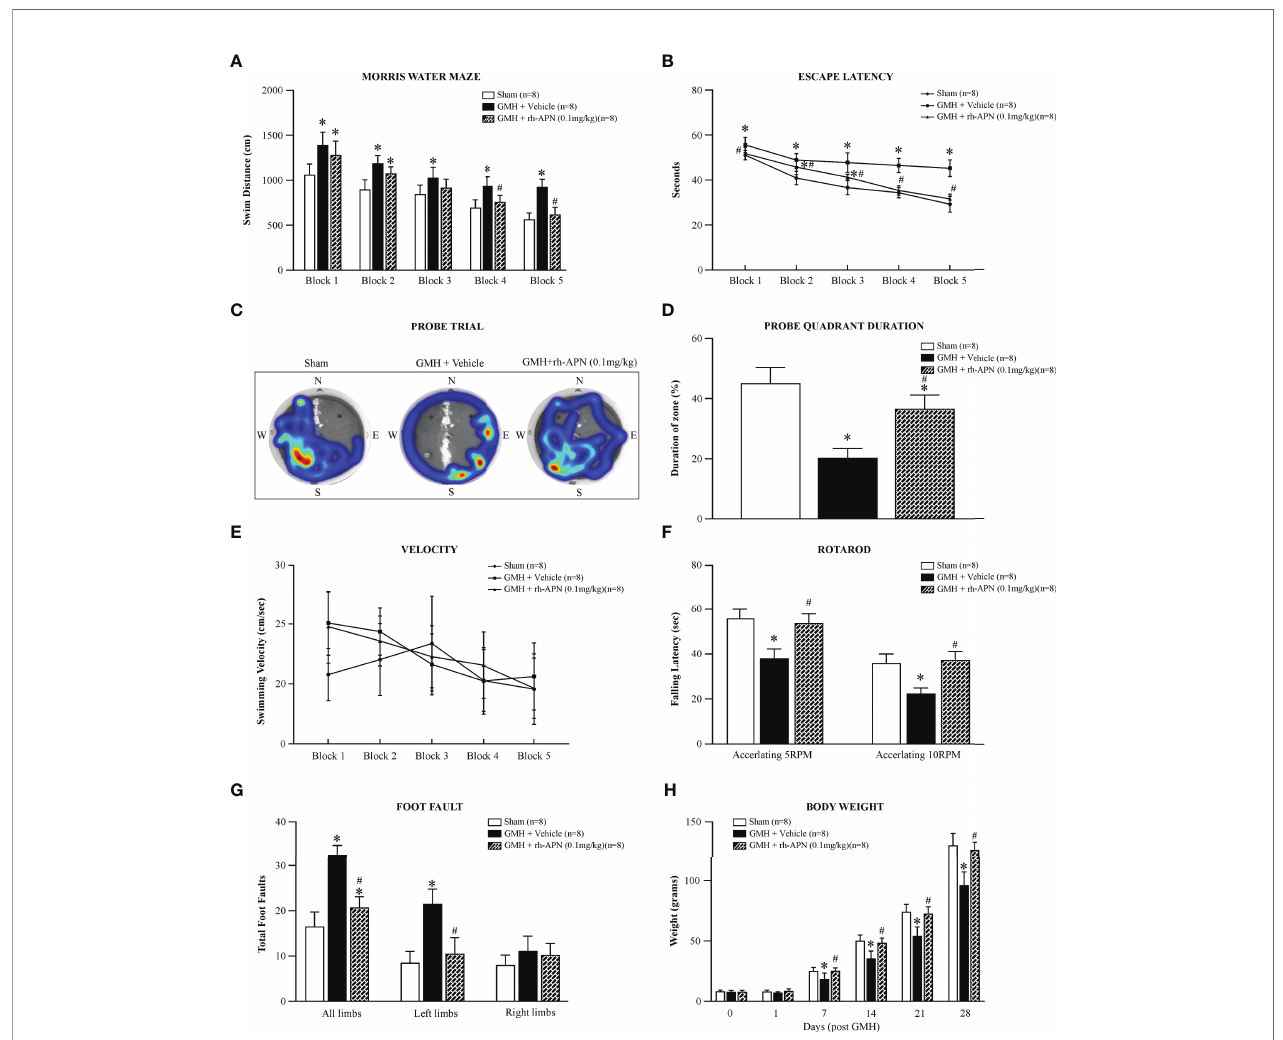
FIGURE 3 | rh-APN administration improved long-term memory and motor function at 21 to 28 days after GMH. Water maze test (A – E) showed that rh-APN treatment signi fi cantly improved spatial learning and memory performance with reduced swim distance to fi nd the platform (A) , less time to escape (B) , and more time spent in the probe quadrant (C, D) . However, no signi fi cant difference in swim velocity was found among the three groups (E) . rh-APN treatment notably improved motor function of pups assessed by rotarod (F) and foot fault (G) tests after GMH. (H) Histograms showing the weight changes of pups with or without rh- APN treatment in 4 weeks post-GMH. Values are expressed as mean ± SD. ANOVA, Dunnett. n = 8 for each group. * P < 0.05 compared to sham, # P < 0.05 compared to GMH +